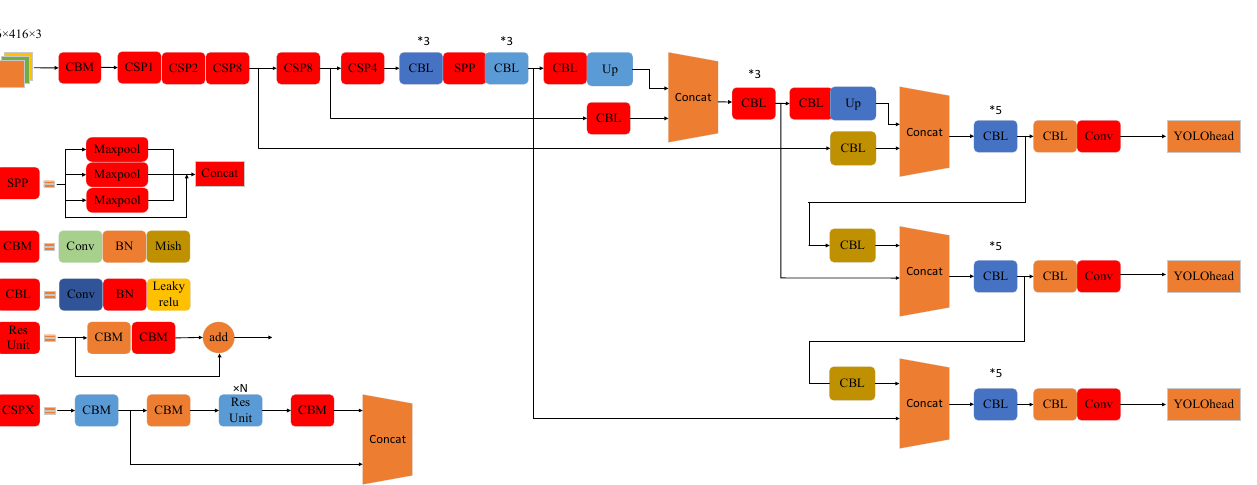
Figure 3. Structure diagram of YOLOv4 model. Note: CSPX stands for cross-stage partial structure, Conv stands for convolutional, BN stands for batch norm, CBL stands for Conv+Batch BN+Leaky- relu-activation-function-synthesis module, CBM stands for Conv+BN+Mish-activation-function- synthesis module, ResUnit stands for the residual connection module, Concat stands for the feature- concatenation operation, Up stands for upsampling operation, Maxpool stands for the pooling op- eration, *3 and *5 stand for the number of repetitions of the CBL module.